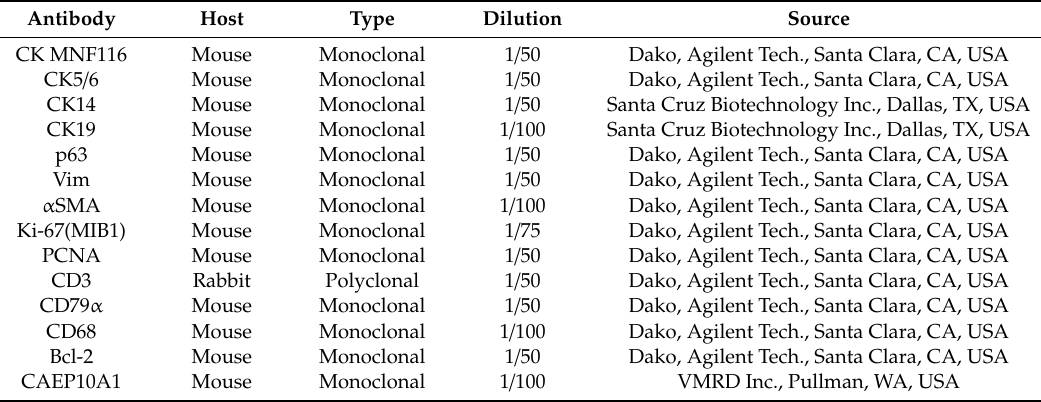
Table 1. The antibodies used for immunohistochemical